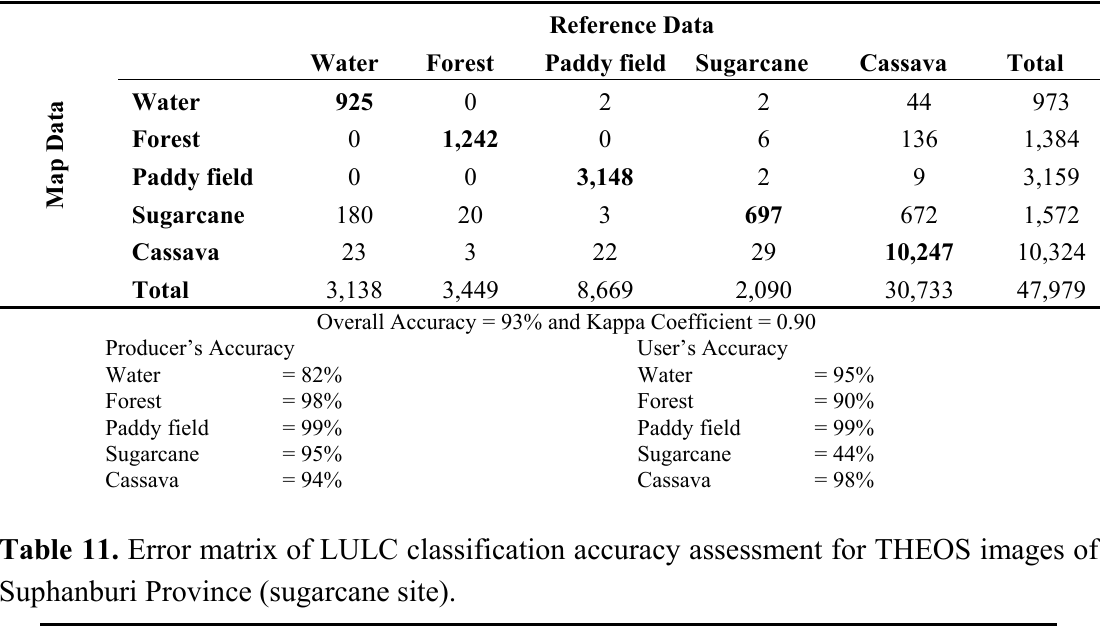
Table 10. Error matrix of LULC classification accuracy assessment for Landsat 5 TM images of Nakhon Ratchasima Province (Cassava site).